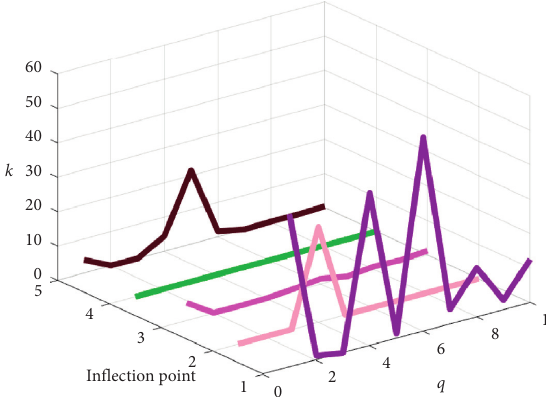
Figure 3: Stationary wavelet domain sinusoidal transformation